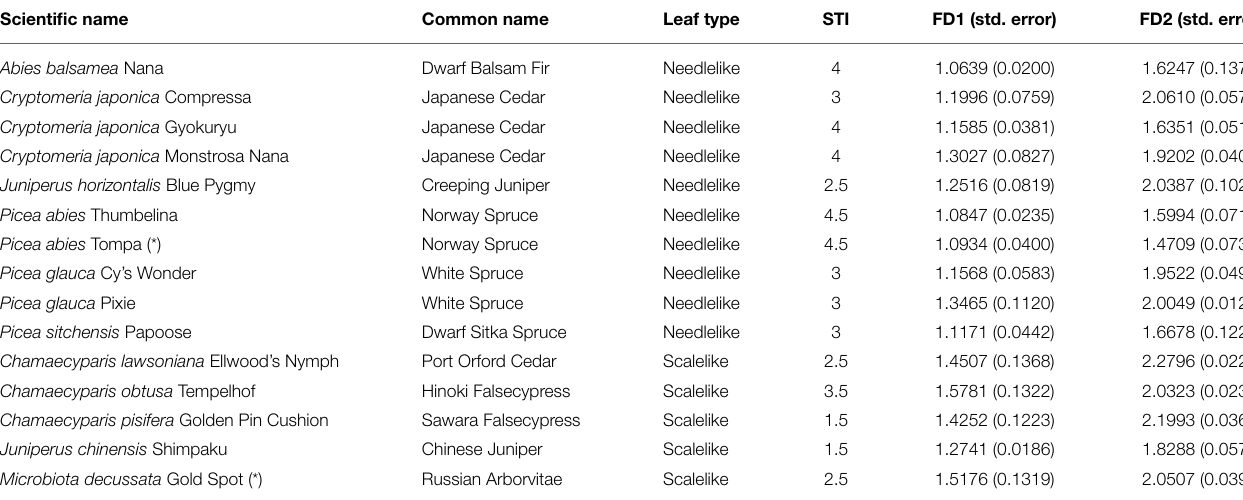
TABLE 2 | Scientific and common species names of the 15miniature conifers, their leaf type and shade tolerance index value, and the estimates and associated standard errors of the two fractal dimensions of their branching pattern.